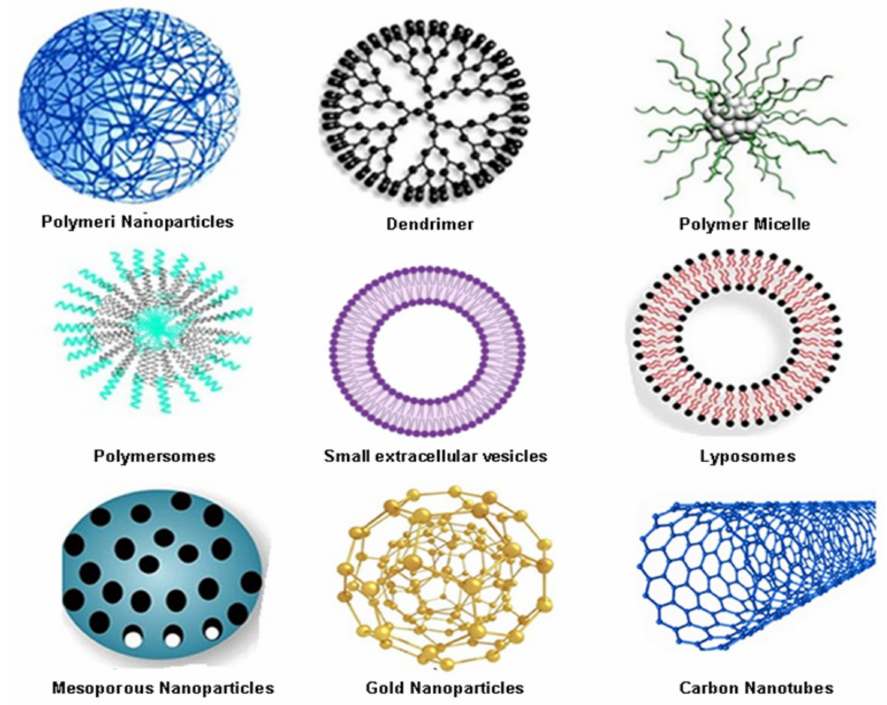
Figure 3. Types of nanomaterials in laboratory, preclinical, and clinical oncology practice. Images are adapted from